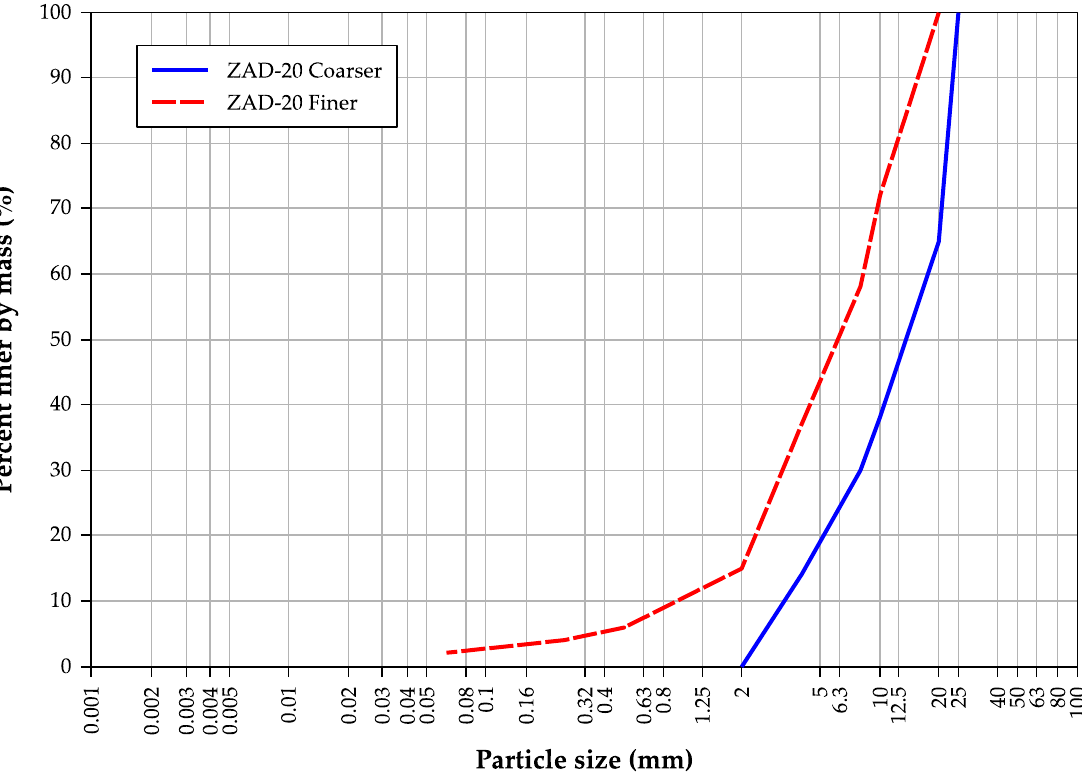
Figure 3. Finer and coarser boundaries of the particle grain distribution for a ZAD-20 [15].